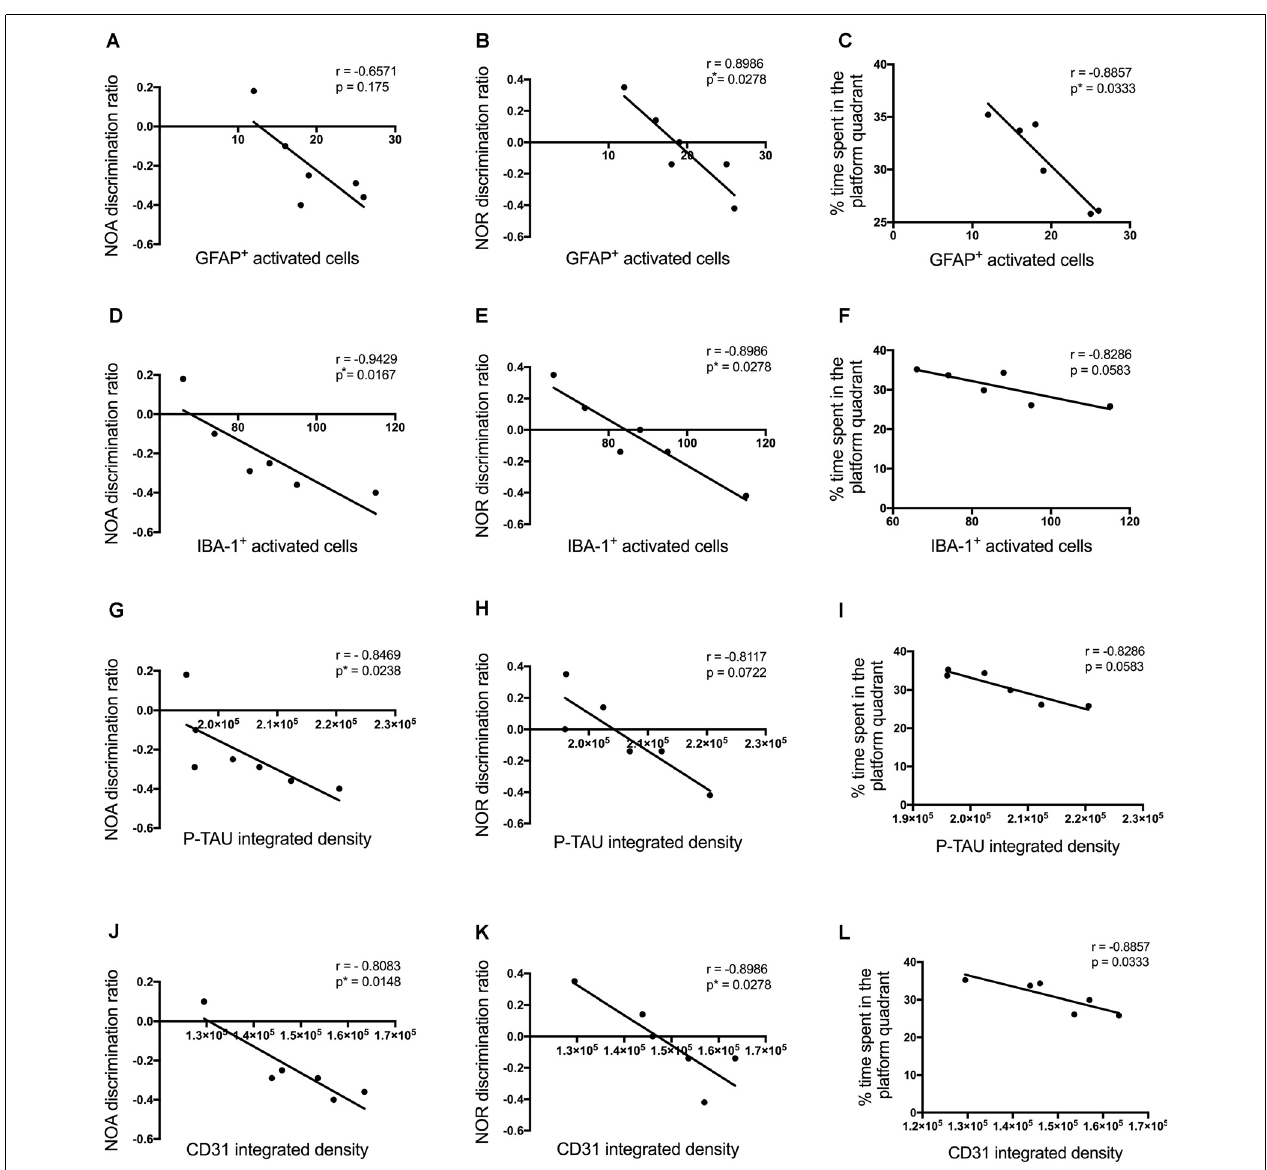
FIGURE 10 | Correlation between the number of activated astrocytes and microglia (A–F) , p-tau (G–I) , CD31 (J–L) at the injection site in the CA1 hippocampal region, and behavioral scores 30 days post-injection in NC, ACSF-, scrA β 1–42 - and A β 1–42 -injected mice. This relationship is represented by a Spearman’s r -value (* p < 0.05, n =